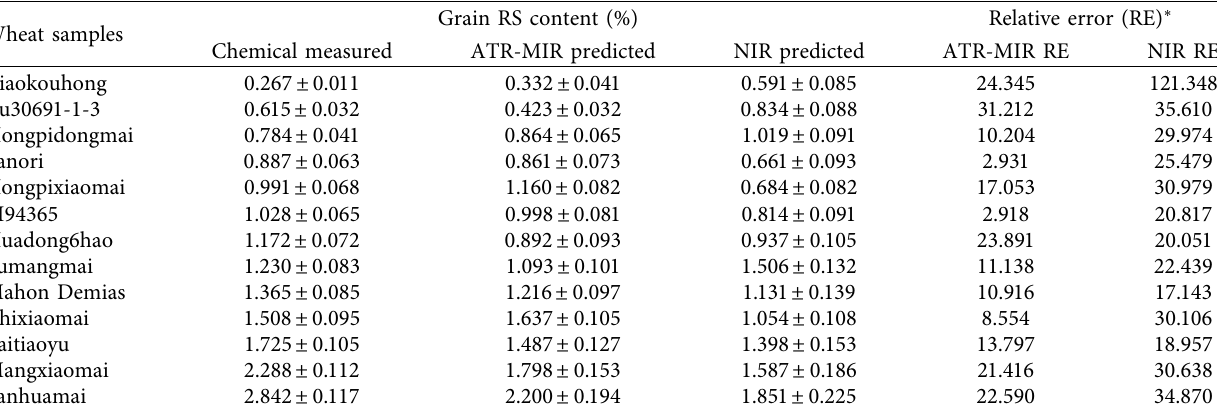
Table 2: Wheat samples in the validation set and grain RS content determined by both the chemical method and the best ATR-MIR and NIR calibration models. Wheat samples